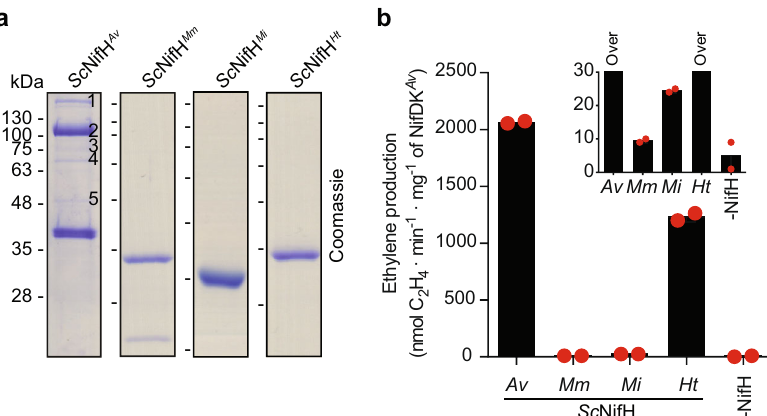
Fig. 2 Activity of selected NifH variants puri fi ed from mitochondria of aerobically cultured S. cerevisiae engineered strains. a STAC-puri fi ed Sc NifH Av (strain XJ4Y), Sc NifH Mm (strain XJ2Y), Sc NifH Mi (strain XJ3Y), and Sc NifH Ht (strain XJ1Y) proteins. The low solubility of Sc NifH Av promoted binding of contaminating proteins (as column was not saturated with Sc NifH Av ) that were identi fi ed by peptide mass fi ngerprinting as: 1) Acc1p (N1P4Q3), 2 and 3) pyruvate carboxylase (N1P377), and 4) HSP70 (D2J4C2). No identi fi cation was possible for band number 5. Uncropped gels are shown in Supplementary Fig. 9. b ARA of STAC-puri fi ed Sc NifH Xx variants. Activity using NifH Av and NifDK Av (positive control) was 2406 ± 53 units (nmol ethylene formed per min and mg of NifDK Av ). Data represent mean values ( n = 2 technical